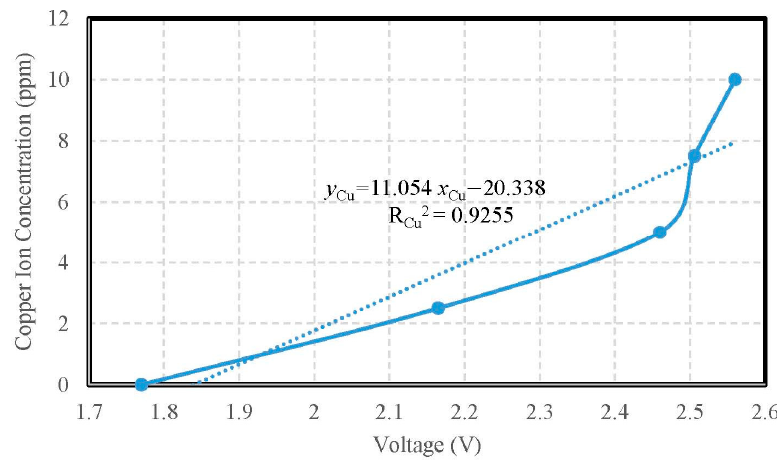
Figure 14. The calibration curve of copper ion concentration.